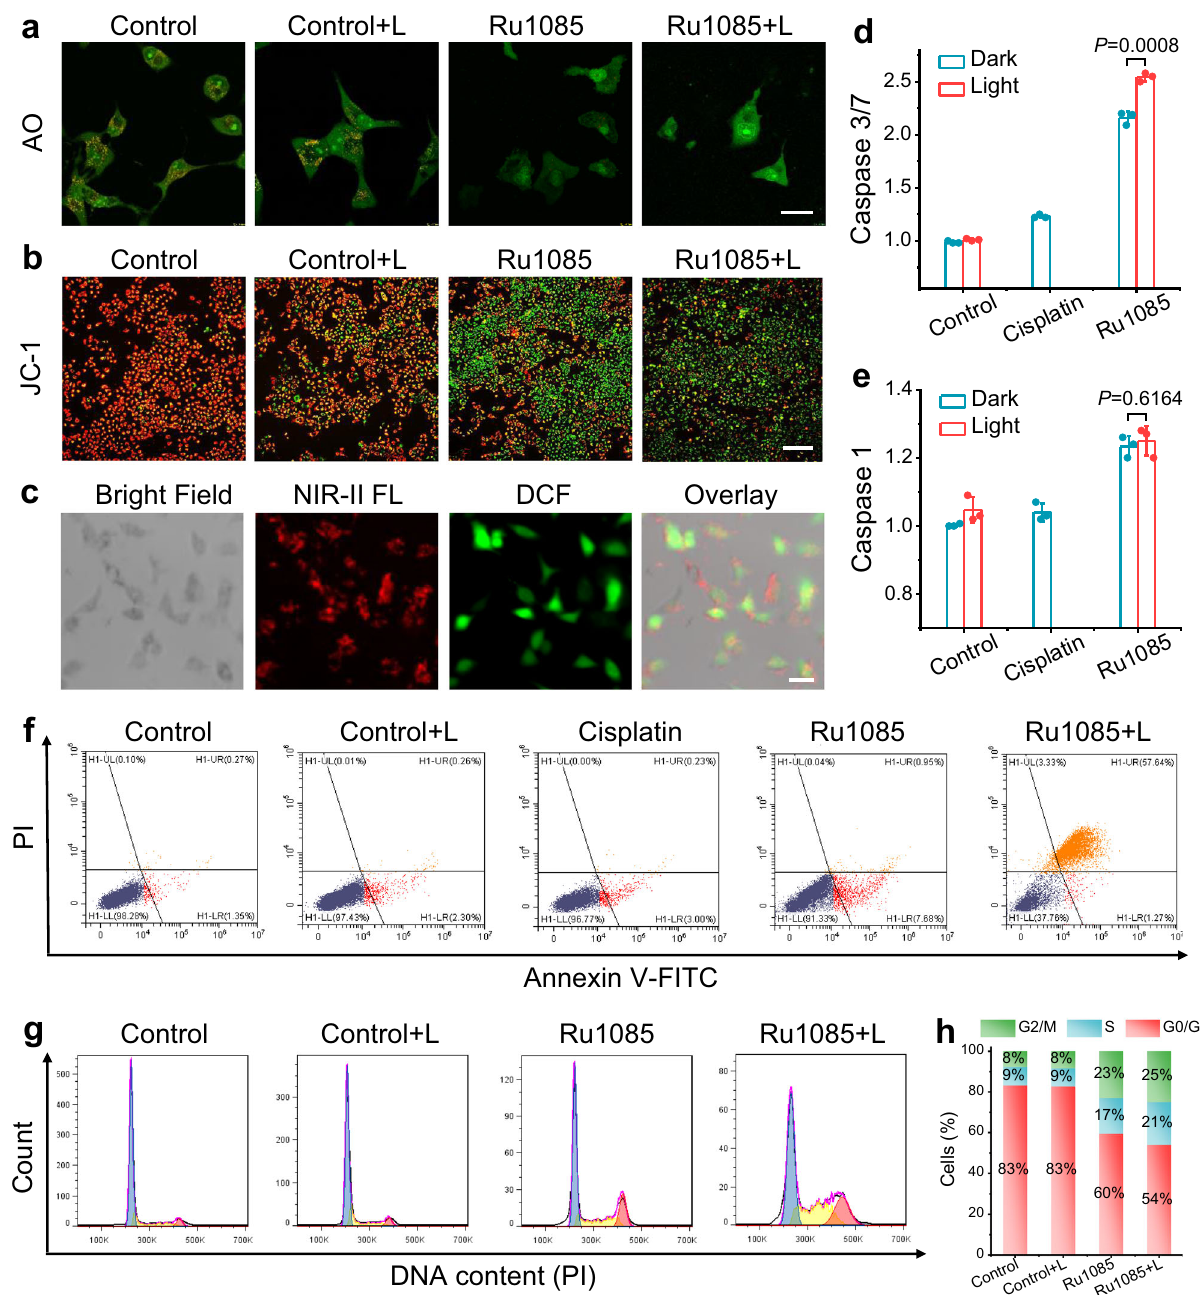
Fig. 5 Antitumor mechanism of Ru1085 in A549 cells. After incubated with Ru1085 (10 μ M) or serum-free medium and treated with or without 808 nm laser illumination (0.8 W cm − 2 , 5 min), cells were taken a AO and b JC-1 staining. Scale bars, a : 20 µ m; b : 300 µ m. c H 2 -DCFH staining of cells treated with Ru1085 along with laser illumination. Scale bar, 20 µ m. Relative caspase 3/7 ( d ) and caspase 1 ( e ) activity after various treatments ( n = 3). f Flow cytometer results of Annexin V-FITC/PI double-stained cells after various treatments. g Cell cycle analysis of cells after various treatments. h Histogram depicting of the cell population distribution in cell cycle phase in ( g ). Data were presented as mean ± s.d. ( n = 3). Statistical differences were analyzed by Student ’ s two-sided t -test. Source data are provided in Source Data fi